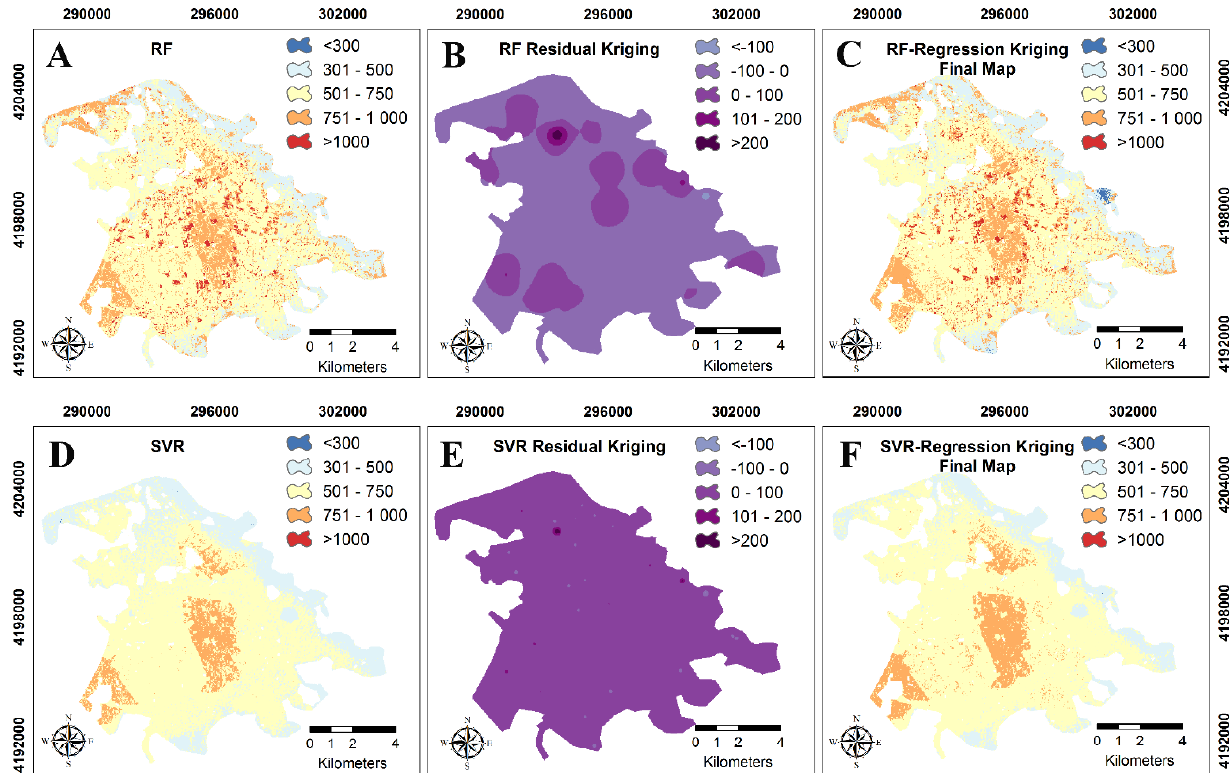
Figure 4. Predicted soil EC map for two algorithms and hybrid techniques. ( A – C ) Random forest predicted EC map, model residuals of RF kriging map, RF-RK final map, respectively. ( D – F ) Support vector regression indicated EC map, model residuals of SVR kriging map, SVR-RK final map, respectively.